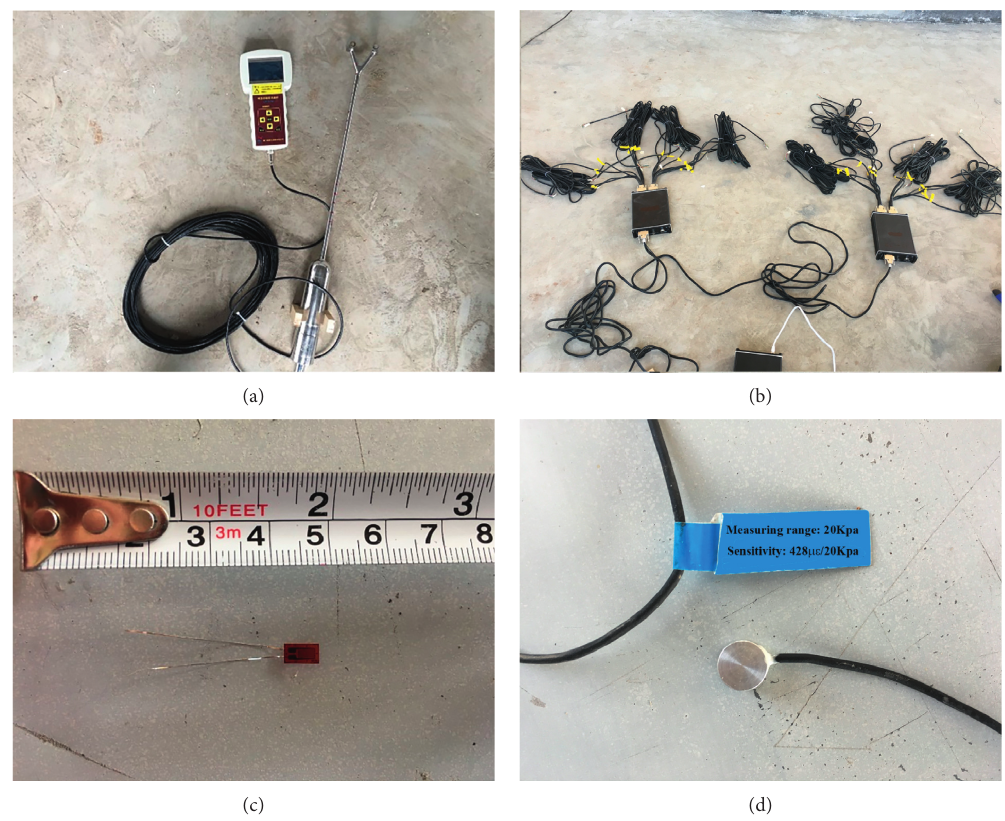
Figure 5: Physical image of the monitoring system: (a) acoustic Doppler velocimetry, (b) data acquisition unit, (c) strain gauge, and (d) pressure